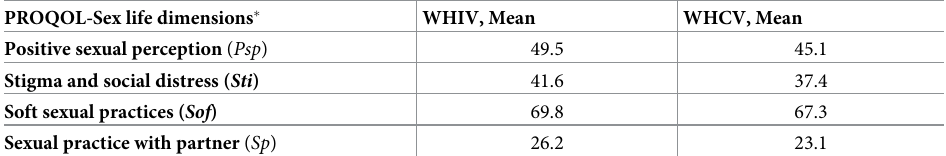
Table 2. PROQOL-Sex life